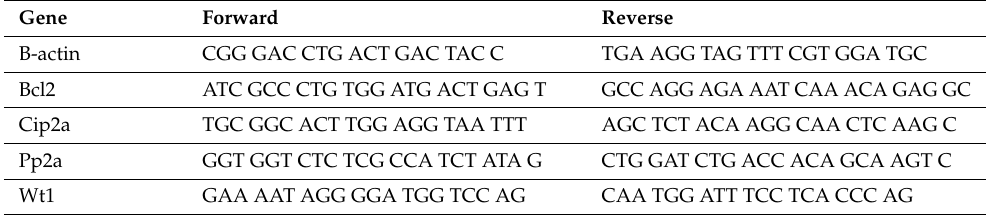
Table 1. Shows the sequence of nucleotides for the designed primers used in this study: